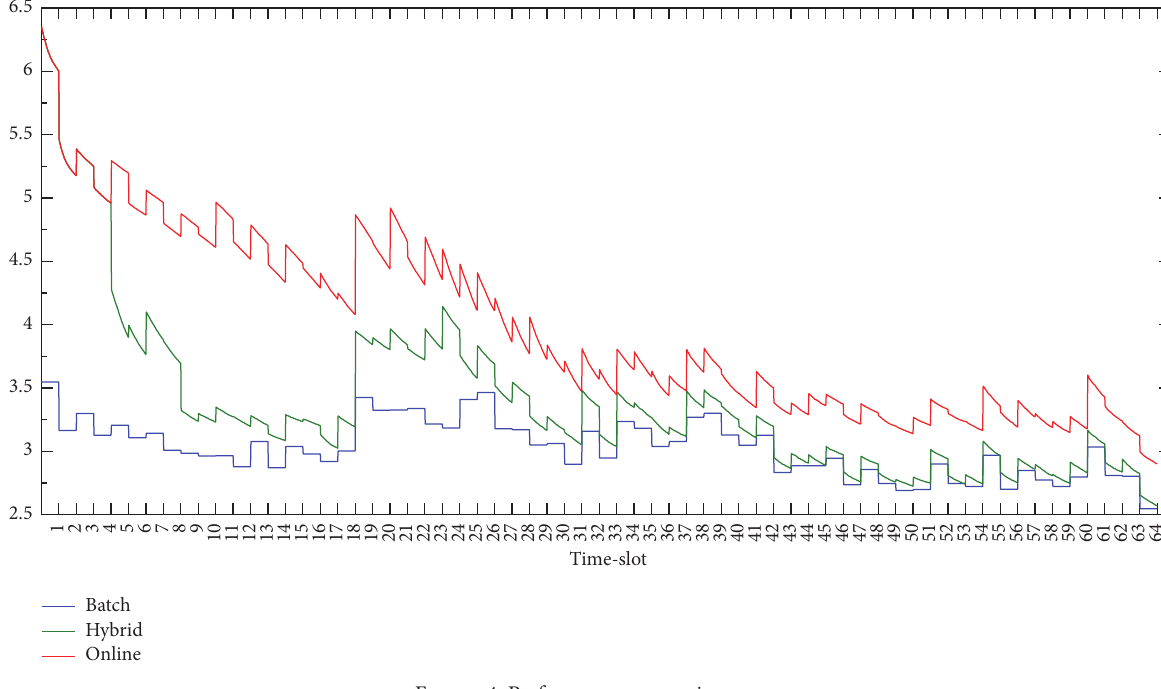
Figure 4: Performance